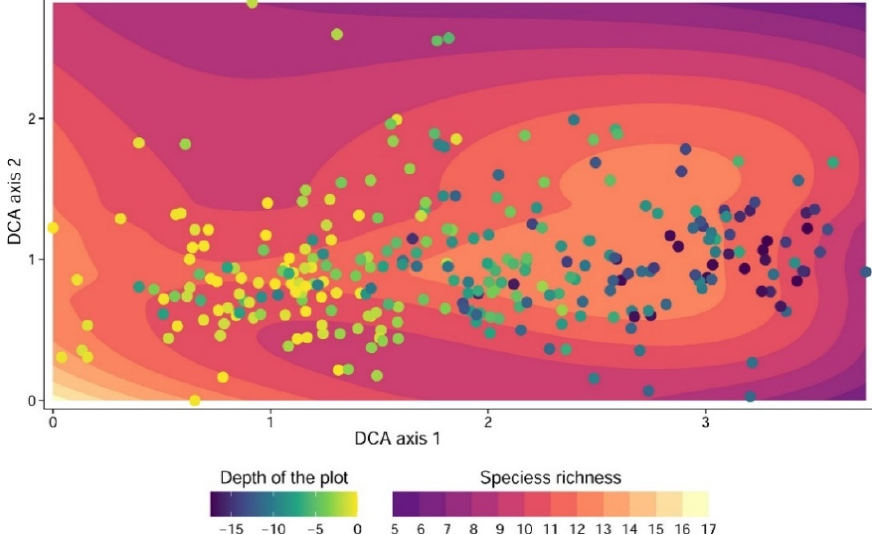
Figure 2. Detrended correspondence analysis (DCA) diagram of vegetation plots. The first two axes are presented (eigenvalues are 0.49 and 0.26). At the same time, the number of species in the plots is interpolated into the background of the diagram plane. Each plot is colored according to its depth. It can be observed that only plots from the deepest dolines are positioned along the whole gradient, while all plots from shallow dolines are positioned only in the left-hand part of the gradient (Figure